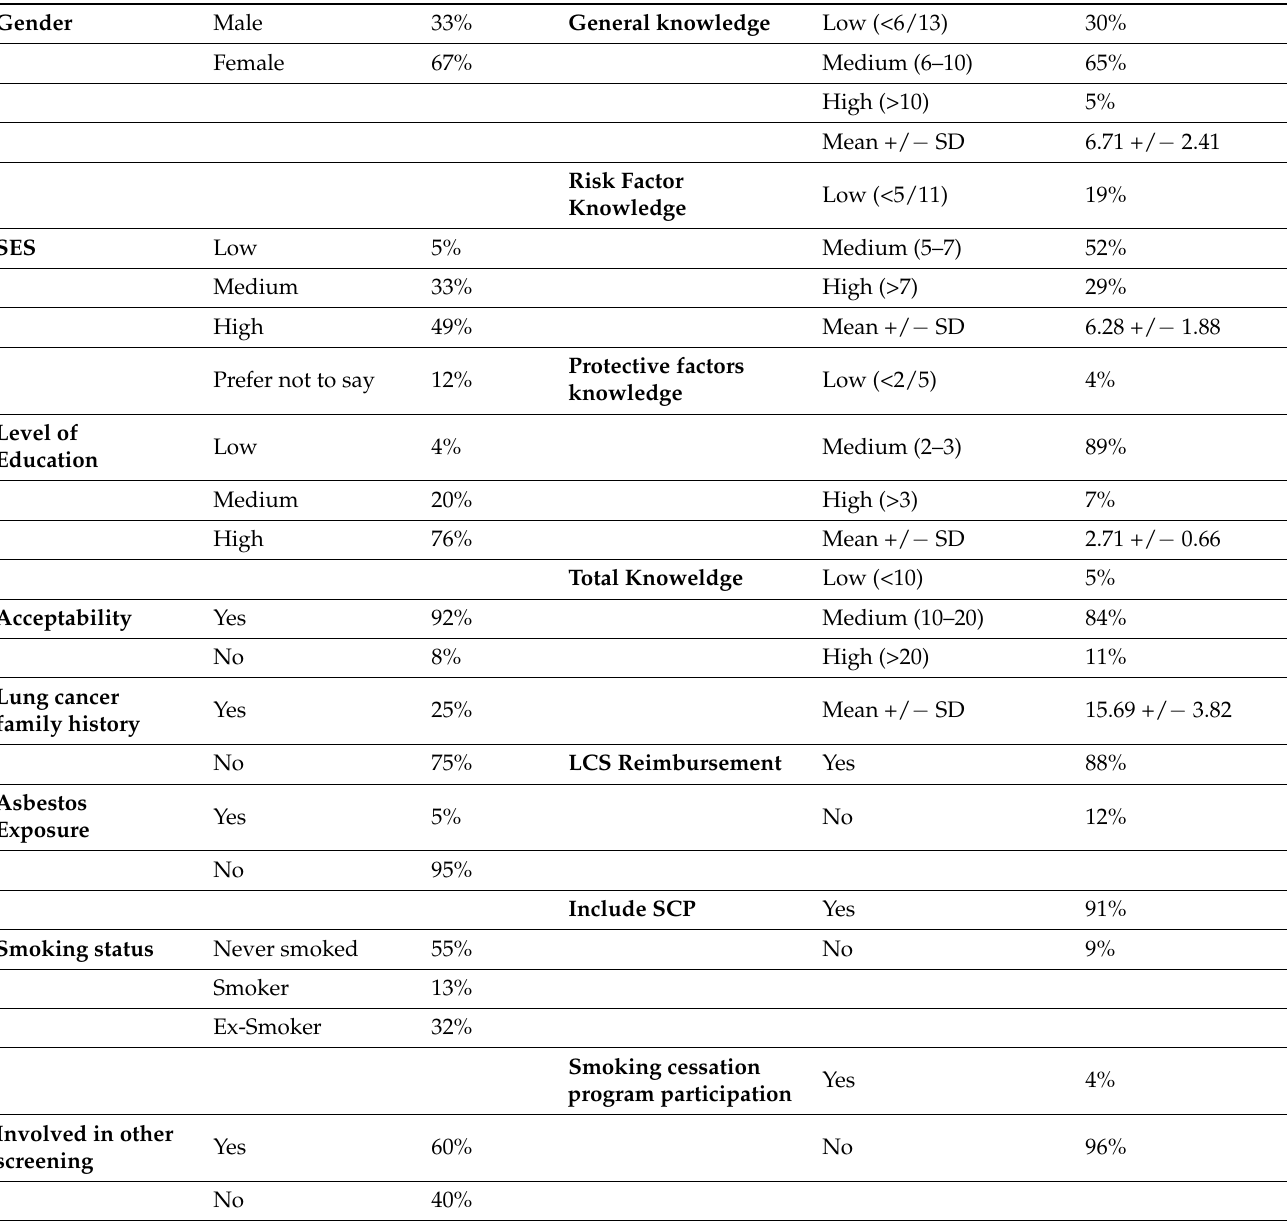
Table A3. Descriptive statistics of variables without missing data collected by online forms (n =